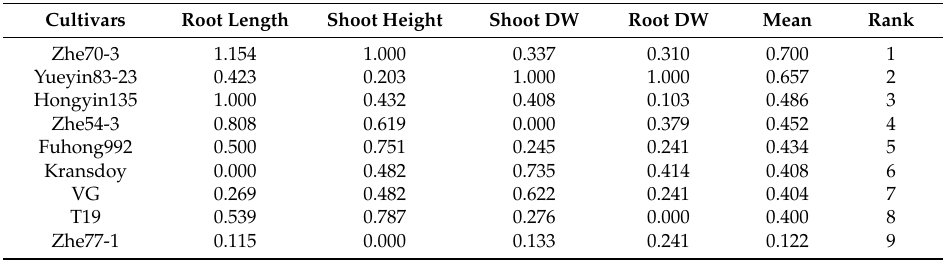
Table 1. Subordinate function values of the Tolerance Index of kenaf grown in Cr-treated Hoagland nutrient